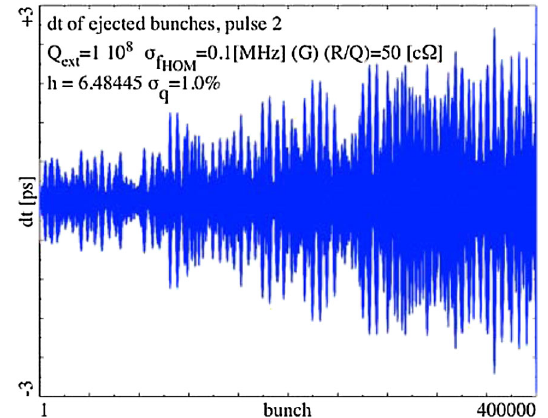
FIG. 64. (Color) dt [ (cid:3) 3 ps ] for the last bunch of pulse 2 along the linac. The corresponding plots (not shown) to conditions of Fig. 6 (no noise) and Fig. 7 (phase noise) show considerably smaller dt excursions.